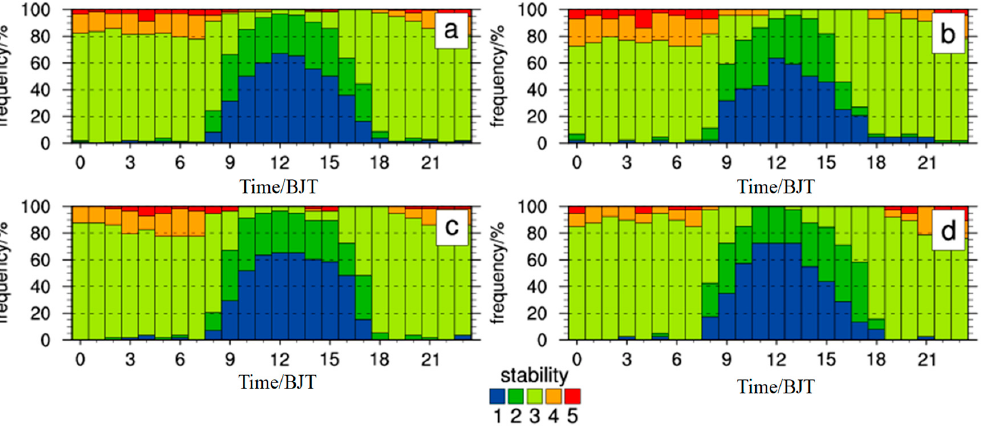
Figure 4. The diurnal variation of atmospheric stability at site 1. ( a ) 9 January–20 March 2020; ( b ) January; ( c ) February; and ( d ) March. Stability level 1: unstable; 2: weak-unstable; 3: neutral; 4: weak-stable; and 5: stable. Table 3. Categories of 𝐿 and atmospheric stability.